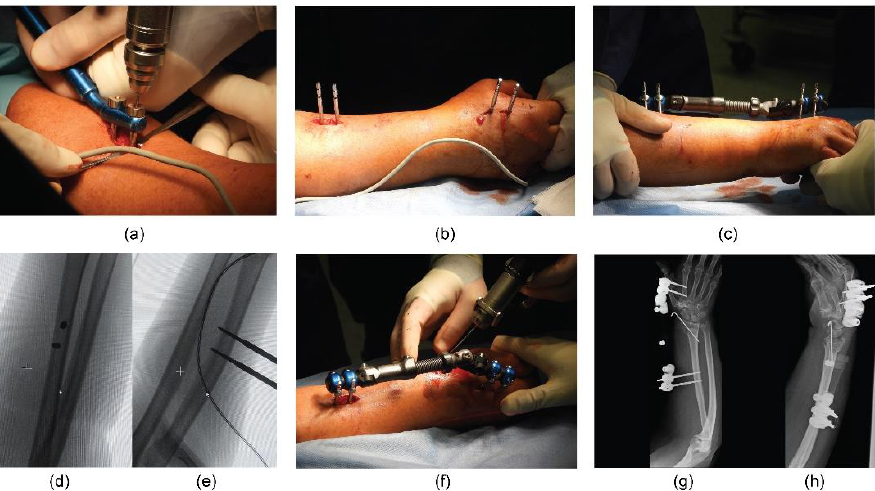
Figure 3. Intra-operative images showing: ( a ) insertion of the pins in the radial diaphysis between the middle third and the distal third of the forearm; ( b ) all pins positioned correctly; ( c ) final application of BEF; ( d ) antero-posterior (AP) and ( e ) latero-lateral (LL) fluoroscopic views of the proximal pins; ( f ) insertion of the KW at the radial styloid level. Post-operative radiographic images: ( g ) AP and ( h ) LL views showing proper reduction and stabilisation of the DRF (AO: